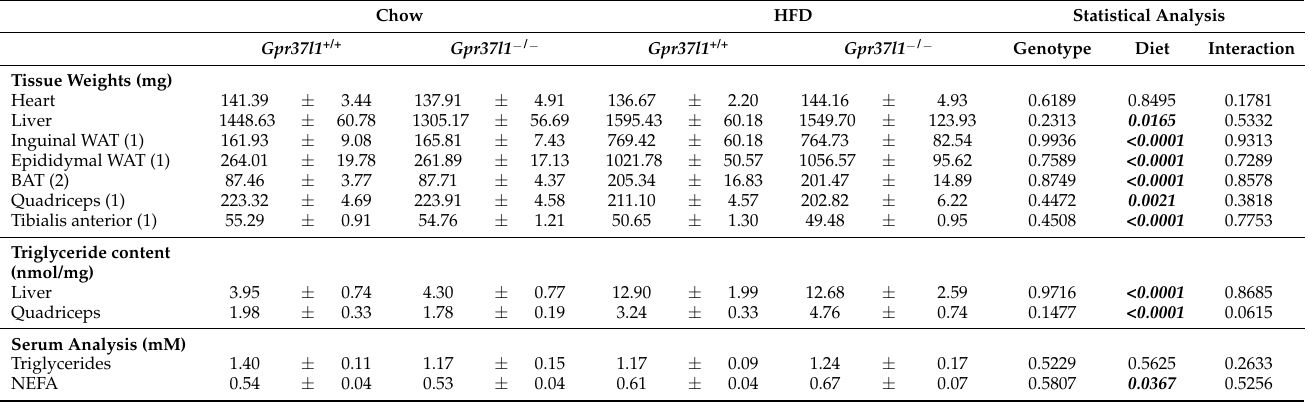
Table 1. High-fat diet and chow-fed Gpr37l1 − / − tissue morphometry and triglyceride and NEFA content.